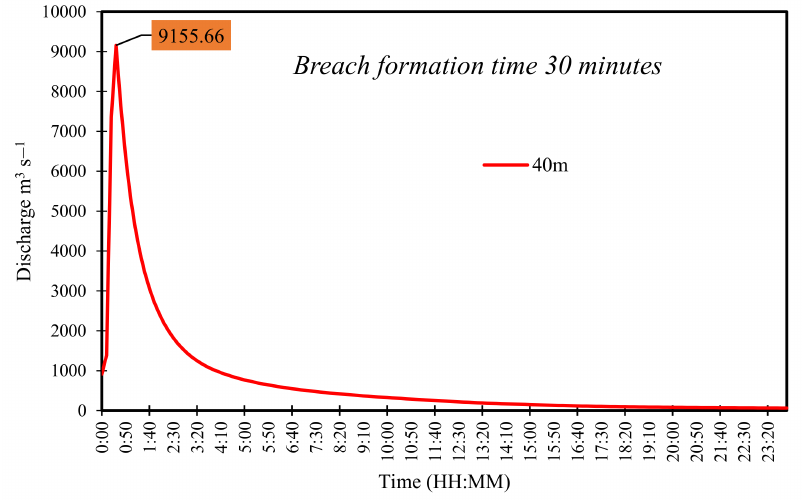
Figure 13. Breach hydrograph in scenario 2 releasing 75% volume of the water from Gangabal